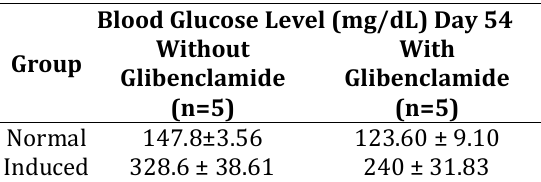
Table I. Insulin resistance test results with